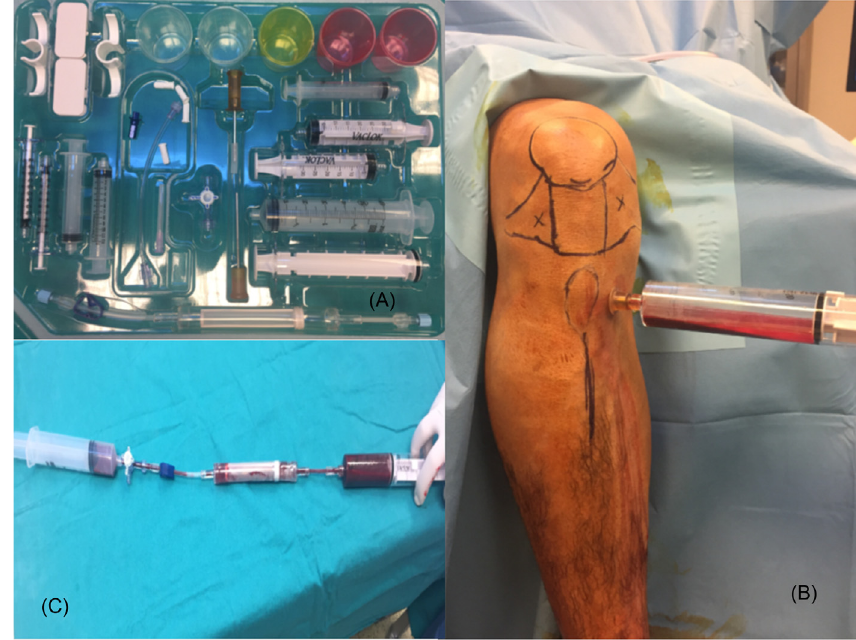
Figure 1. (A) Tibial bone marrow system, (B) harvesting the bone marrow sample, (C) preparing the